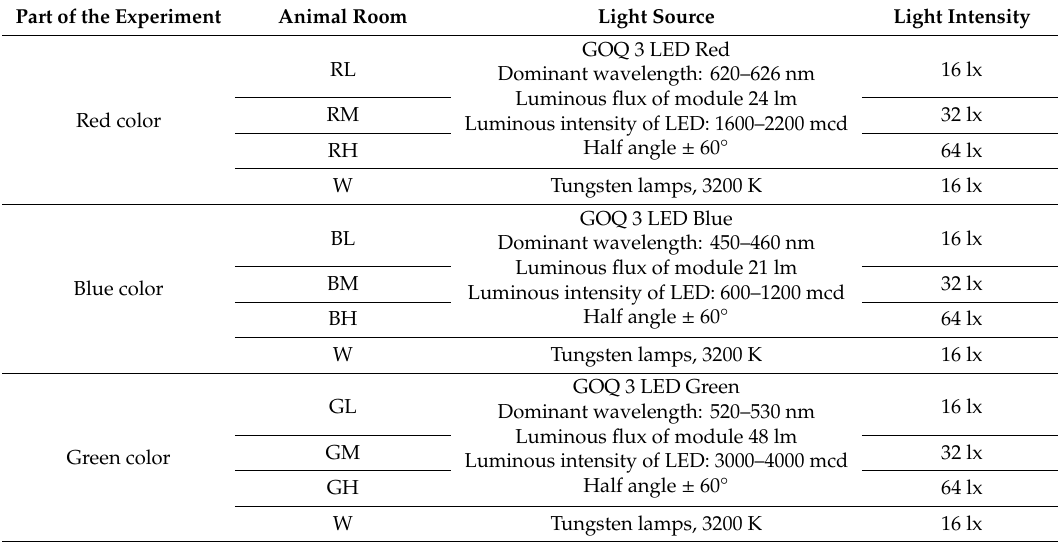
Table 1. Light conditions during the last 7 days of the